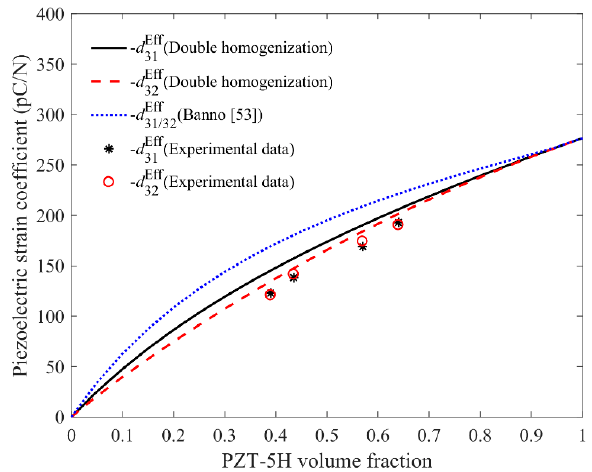
Figure 12. Comparison between the experimental and theoretical values of d Eff